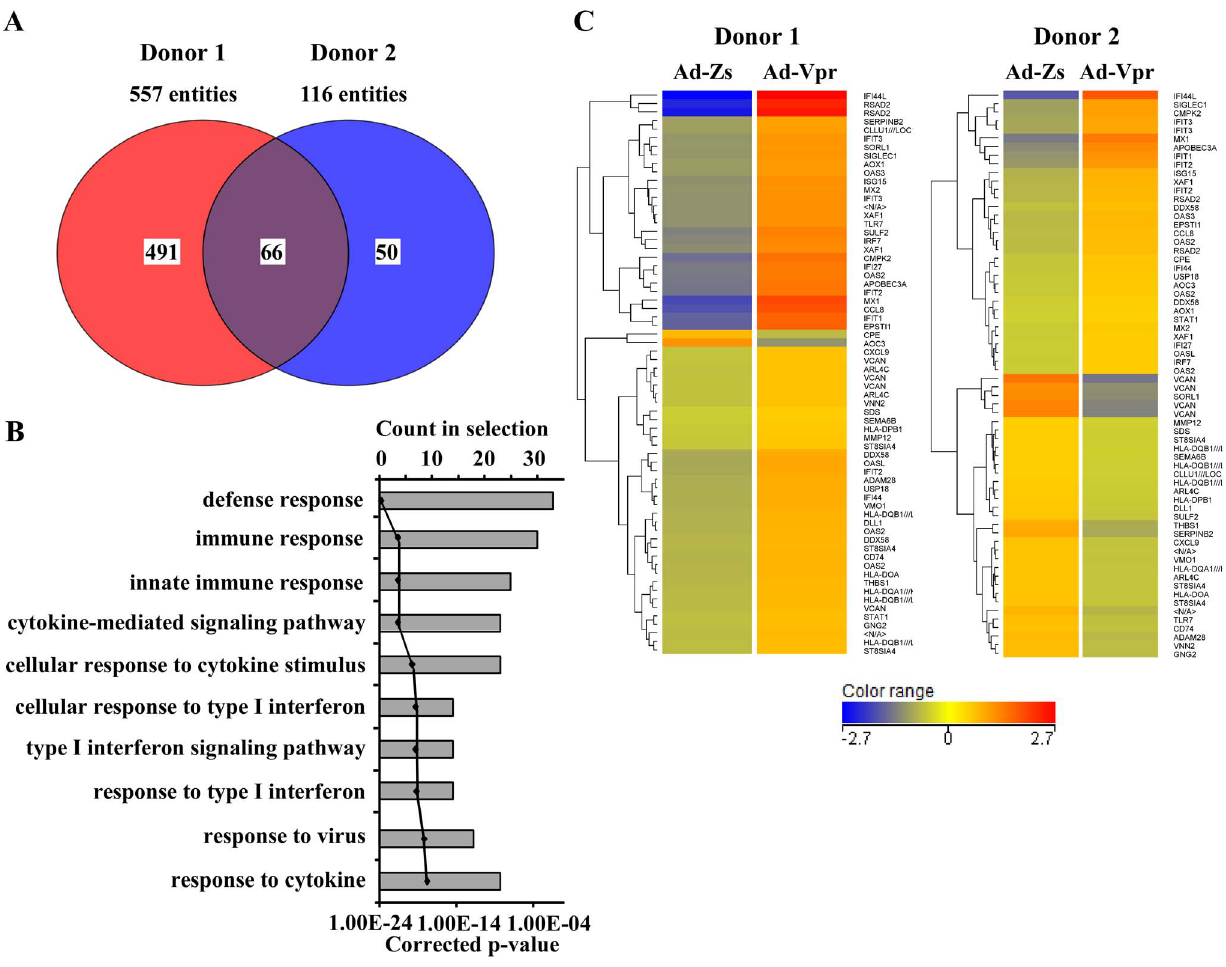
Figure 4. Gene ontology of differentially expressed genes after infection of human monocyte-derived macrophages (MDMs) with Ad-Vpr. (A) Venn diagram representing the number of differentially expressed cellular genes ( . 2-fold change in both donors) after infection of human MDMs with Ad-Vpr. (B) The top ten genes ontology classified by corrected p-value, and (C) heat map of hierarchical gene clustering of the 66 differentially regulated in both donors. Gene up-regulation is denoted in red and gene down-regulation is denoted in blue.